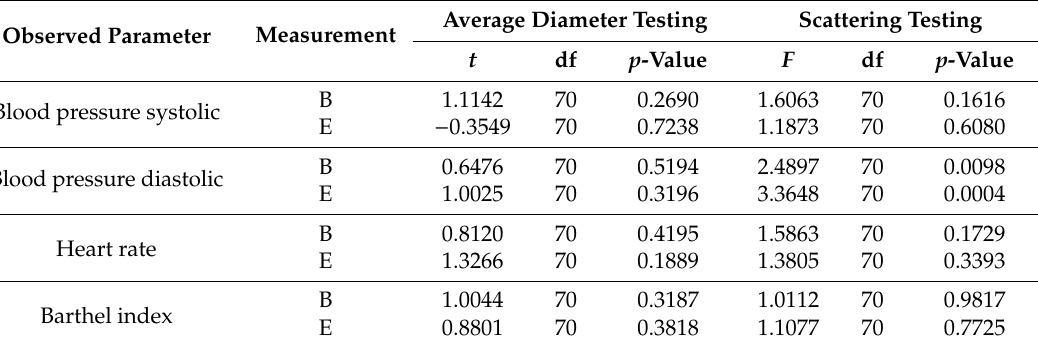
Table 3. Results of testing di ff erences between groups ( t -tests were used for independent samples). Observed